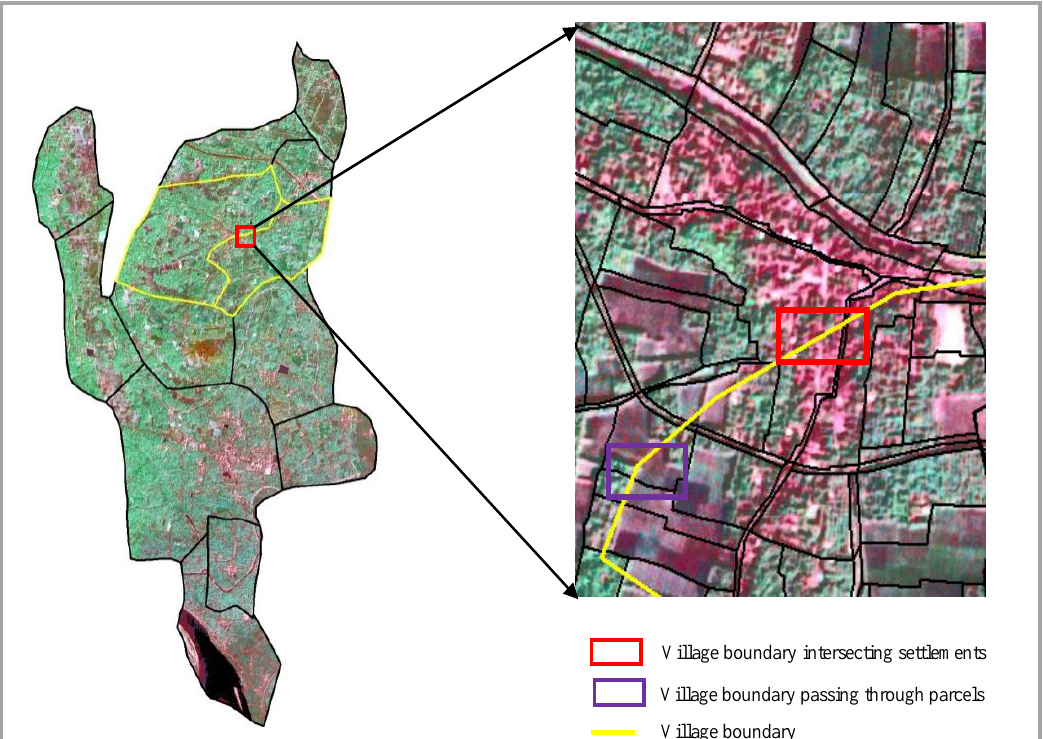
Figure 9: Village boundary 2001 overlaid on HRSI